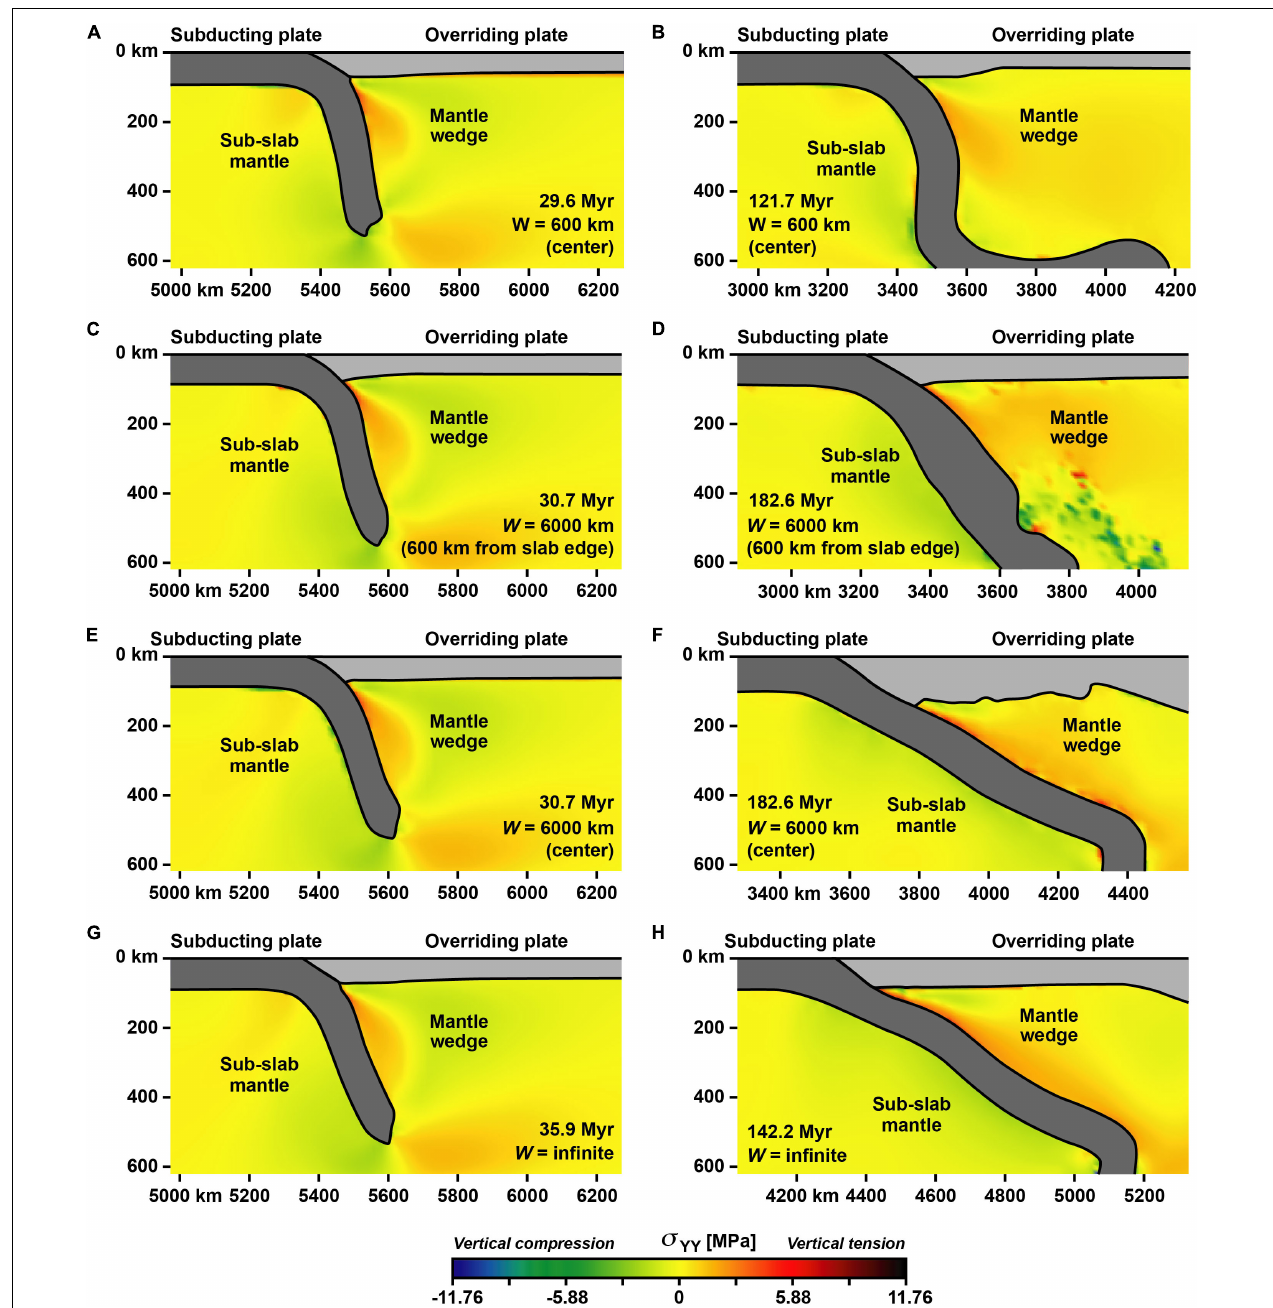
FIGURE 6 | Cross-sections through three numerical subduction models with a different slab width showing the vertical deviatoric normal stress ( σ YY ) in the mantle wedge and sub-slab region at two stages during the subduction process (early and late stage). (A,B) Cross sections through the center of the narrow slab width model ( W = 600 km) showing relatively low stresses at all times. (C–F) Wide slab model ( W = 6000 km) with panels C,D for a section located 600 km from the closest lateral slab edge and panels E,F for a section located in the center of the subduction zone (3000 km from the lateral slab edges). Low stresses are observed in the early subduction stage (C,E) , intermediate stresses during a late stage near the lateral slab edge (D) and high stresses during a late stage in the center (F) . (G,H) Very wide slab model ( W = infinite, 2D set-up) showing relatively low stresses in the early subduction stage (G) but high stresses in a late subduction stage (H) . Note that the short-wavelength structures in panel (D) (the dark green and red blobs at ∼ 300–600 km depth in the mantle wedge and just below the base of the overriding plate) are formed by slab material from the lateral slab edge that has been advected into the mantle wedge by the rollback-induced toroidal upper mantle return flow. This toroidal flow, which is directed from the sub-slab and around the lateral slab edge into the mantle wedge (e.g., Schellart et al., 2007), has curved and sheared the slab edge into the mantle wedge and has also sheared off small fragments from the slab edge. Additionally, a consequence of the curvature is that the local trench orientation strikes at an oblique angle with respect to cross-section (D) . The slab edge material has a higher viscosity than the ambient upper mantle material and therefore shows higher deviatoric stresses than the ambient upper mantle material.